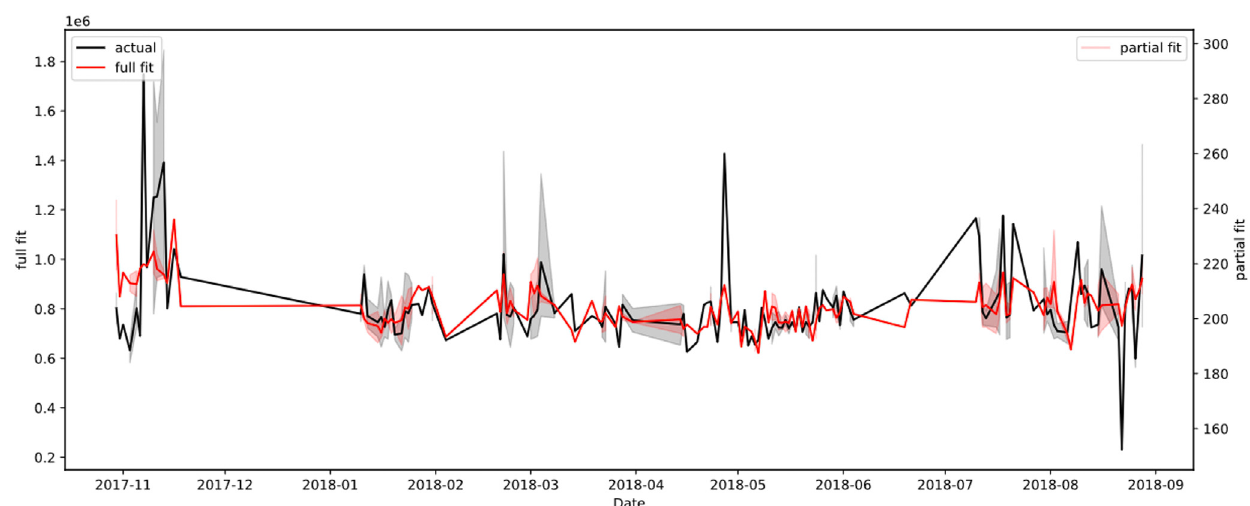
Figure 3. Model of gray brain matter using patient age, patient position in scanner, patient sex, patient weight, total signal-to- noise ratio, and seasonal variation. R 2 value was 0.242. The full fit plot (in red) shows the plot of all independent variables, whereas the partial fit plot (in pink) shows the plot of only the statistically significant variables. The black plot shows the actual fit of the real